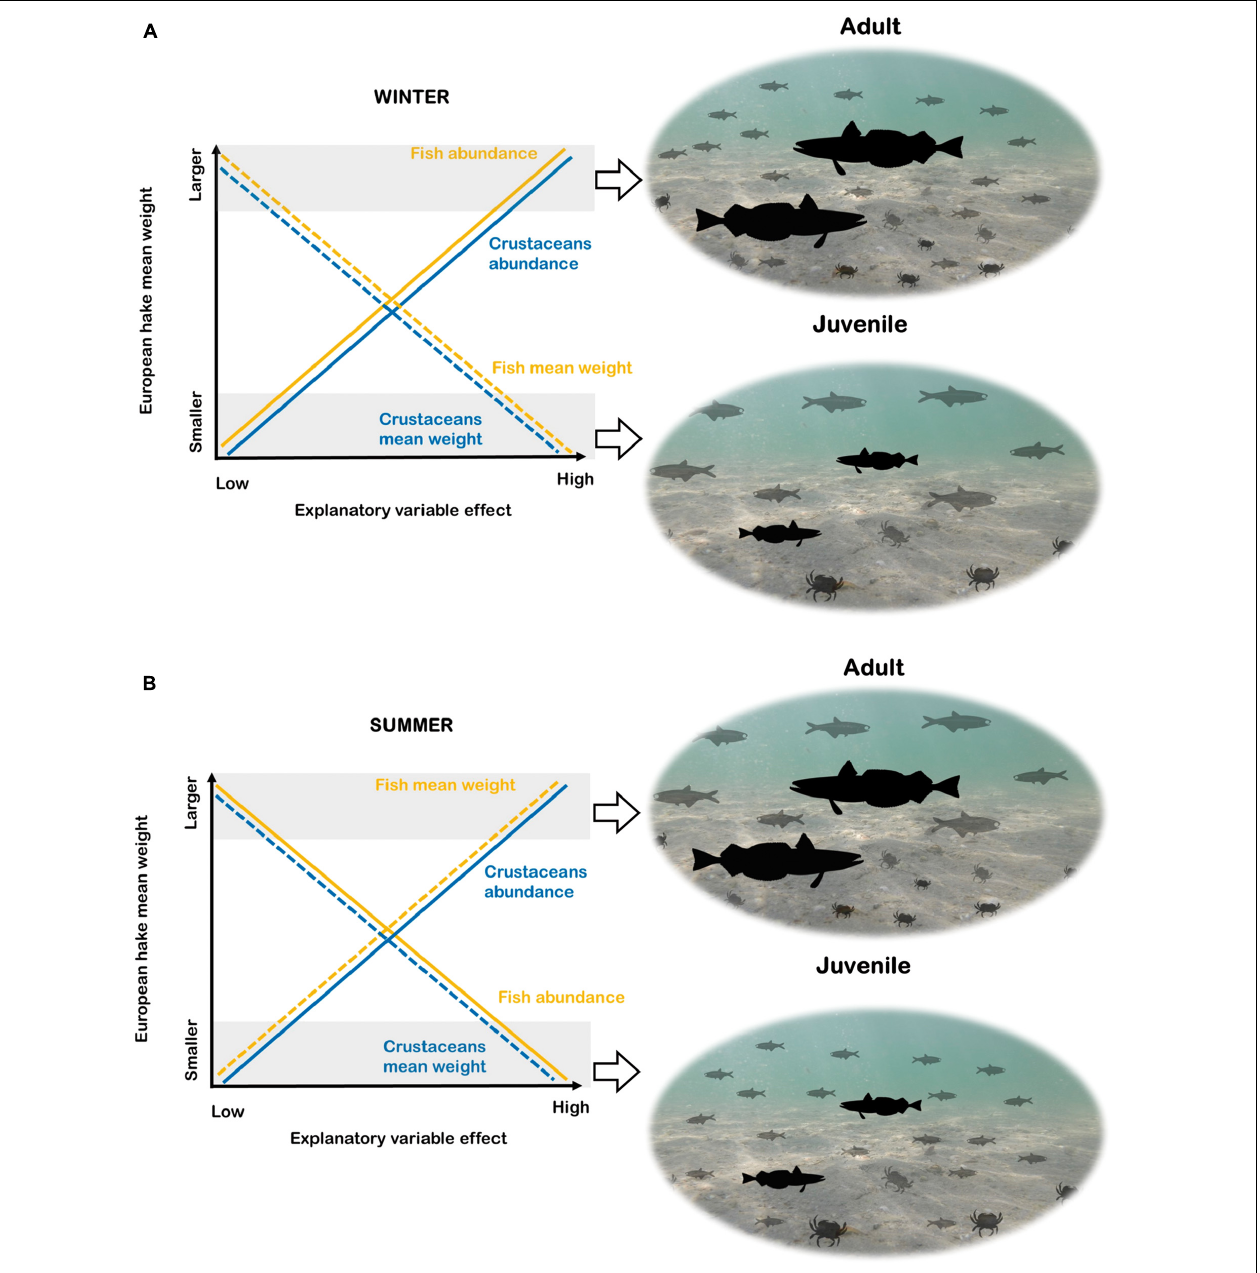
FIGURE 2 | Graphical interpretation of the results for the species distribution models (B-SDM) in winter (A) and summer (B) . The y-axis of the graphs show the response variable (European hake mean weight) and the x-axis the intensity (from lower to higher) of the explanatory variables of “Fish” and “Crustaceans.” The yellow lines represent “Fish” and the blue lines “Crustaceans”. In both cases, the straight line is used to represent the response variables related to abundance and the dotted line the response variables related to mean weight. Images from PhyloPic: European hake (“http://phylopic.org/image/8d92b454-3131-4bbd-ac9c- e1df14c2fc5a/”) this image available for reuse under the Public Domain Mark 1.0, Engraulidae (“http://phylopic.org/image/6bd3702d-3ef1-44d0-83bf-93377 875017c/”) by M. Kolmann this image available for reuse under the Public Domain Mark 1.0 and Liocarcinus depurator “http://phylopic.org/image/01dd976b- f6e9-4204-bae1-c15a32234f73/”) by Hans Hillewaert (vectorized by T. Michael Keesey) this image available for reuse under the Creative commons attribution-share Alike 3.0 Unported.